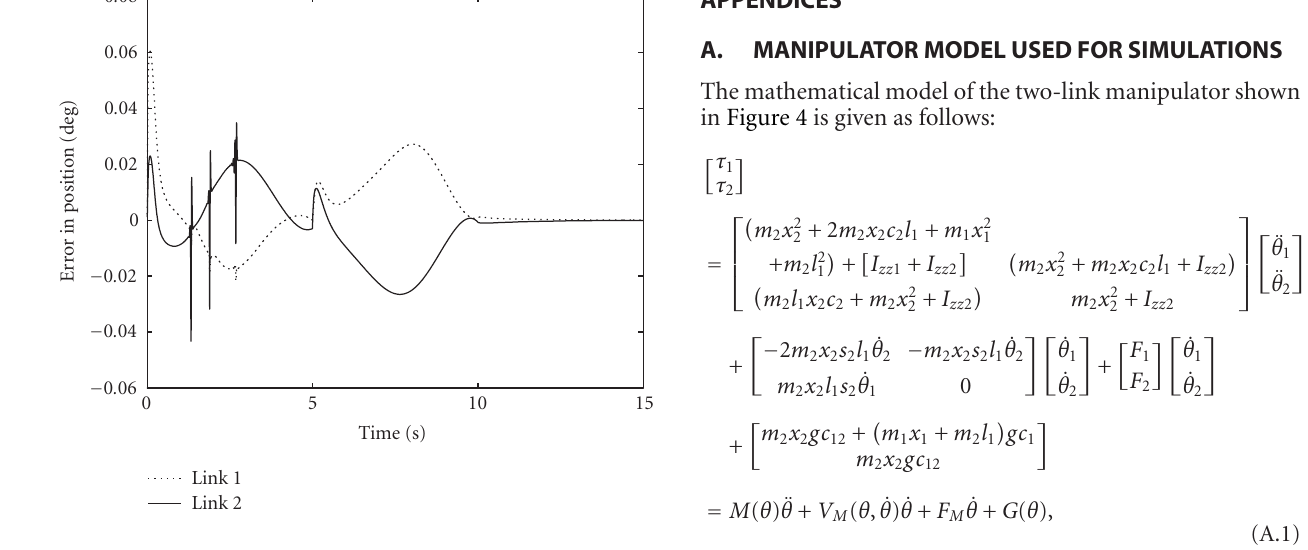
Figure 14: Errors for ACDIDC + fuzzy control (trajectory 1).